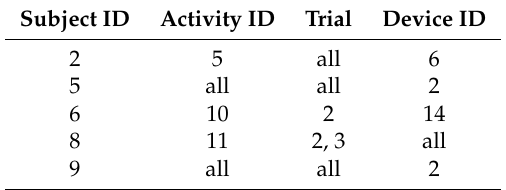
Table 7. Missing values in the UP-Fall Detection dataset.